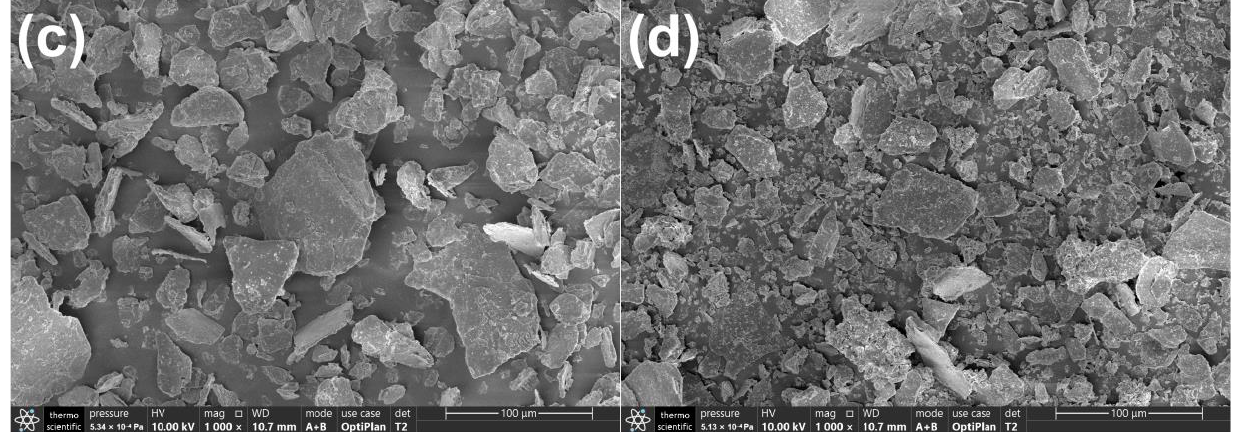
Figure 2. SEM images of Mus ( a ), PT ( b ), TM ( c ) and 1-ATM ( d ).